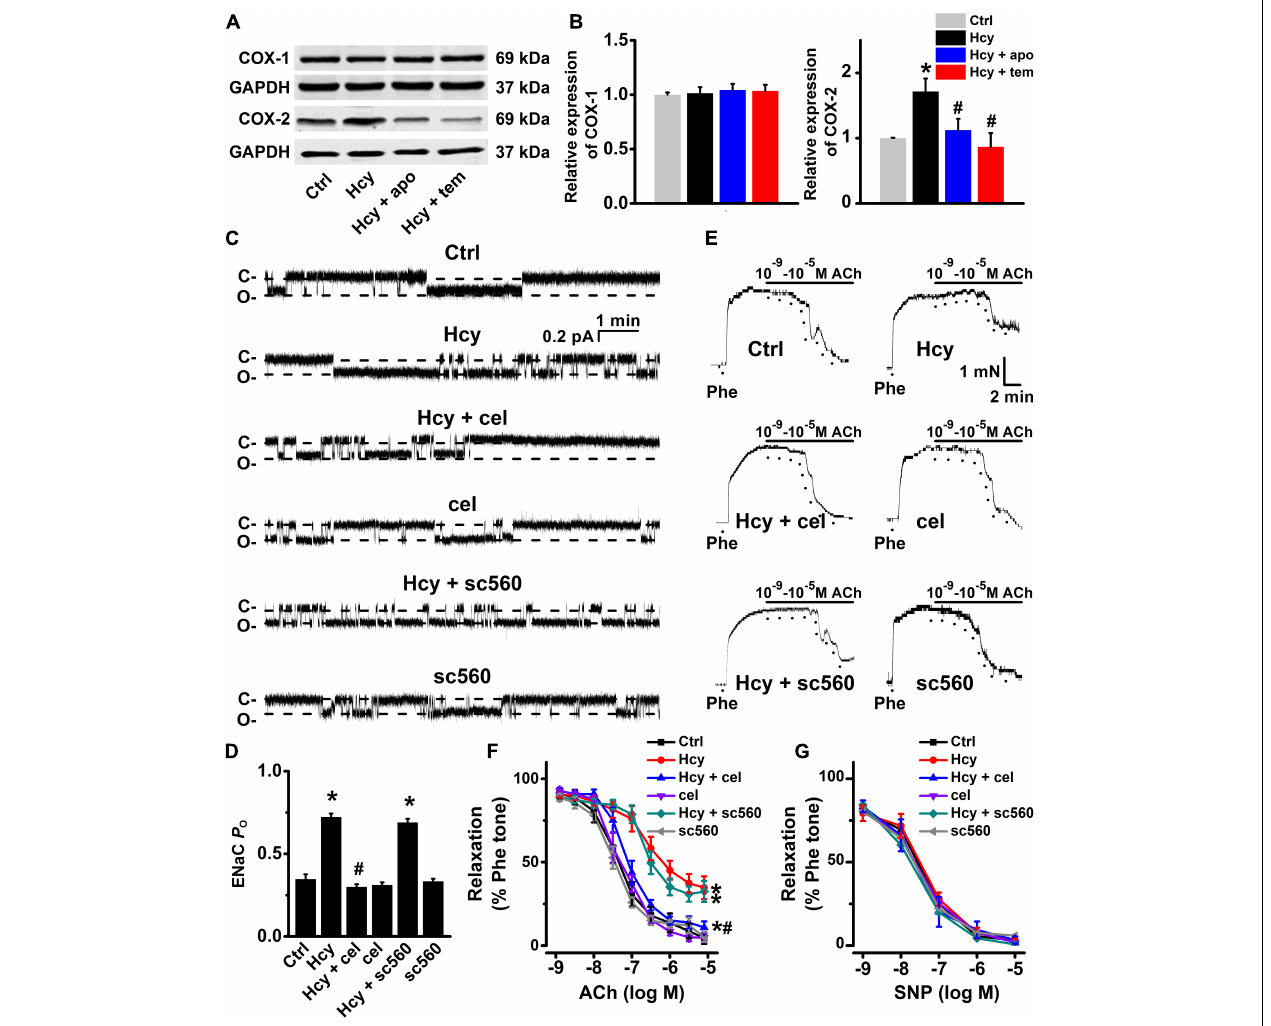
FIGURE 5 | Inhibition of COX-2 by celecoxib attenuates Hcy-induced increase in ENaC activity and impairment of EDR in mouse aorta. (A) Representative Western blots demonstrating COX-1 and COX-2 expression in HUVECs under control condition or treated with 100 µ M Hcy, 100 µ M Hcy plus 100 µ M apocynin (apo), or 100 µ M Hcy plus 100 µ M TEMPOL (tem) for 6 h, respectively. (B) Summary plots of Western blots, showing the expression levels of COX-1 (left) and COX-2 (right) under each indicated condition. Data are means ± SEM of six experiments in each group. * P < 0.05 vs. ctrl; # P < 0.05 vs. Hcy. (C) Representative ENaC single-channel currents recorded in endothelial cells from split-open aorta under control conditions or, respectively, treated with 100 µ M Hcy, 100 µ M Hcy plus 3 µ M celecoxib (cel), 3 µ M celecoxib alone, 100 µ M Hcy plus 0.3 µ M sc560, or 0.3 µ M sc560 alone for 6 h. (D) Summarized ENaC P O , reflecting ENaC activity, from recordings as shown in (C) . Data are means ± SEM of six mice. * P < 0.05 vs. ctrl; # P < 0.05 vs. Hcy. (E) Representative traces obtained from wire myograph assays under each indicated condition and (F) summarized data of ACh-induced relaxation of aorta under each indicated condition. The first dot indicates the application of 10 − 9 M ACh to the 1 µ M Phe precontracted arterial rings, whereas the following dots indicate ACh concentrations gradually increasing from 10 − 8 . 5 to 10 − 5 M. Data are means ± SEM of six mice. * P < 0.05 vs. ctrl; # P < 0.05 vs. Hcy. (G) Summary of artery relaxation induced by 10 − 9 to 10 − 5 M SNP in aorta from the six individual experiments under indicated